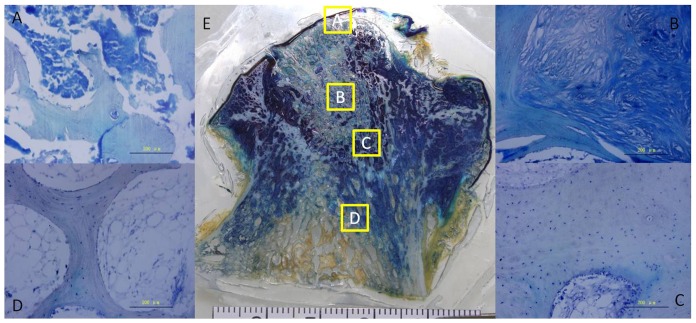
Toluidine blue staining of undecalcified and decalcified bone tissue.Toluidine blue staining of a paraffin section of the subchondral bone (A), necrotic (B), sclerotic (C), and healthy(D) regions. Toluidine blue staining of an undecalcified bone tissue slice of an entire section (E).